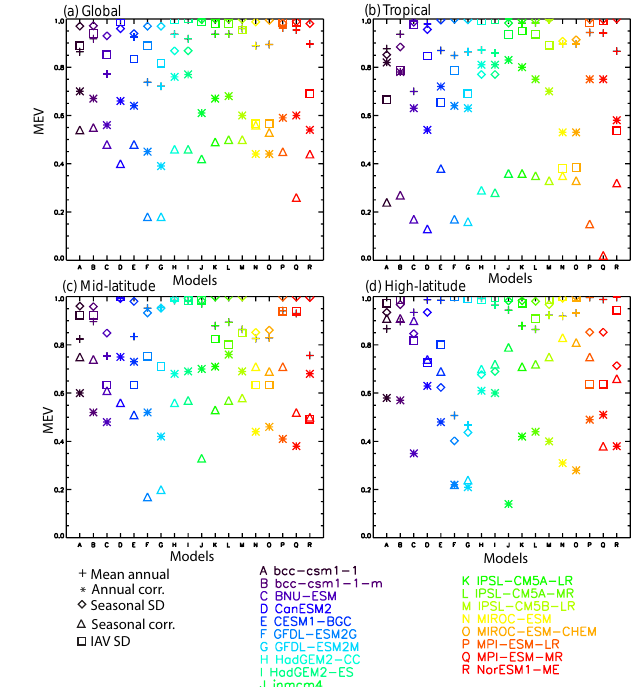
Figure 9. Comparison of model metrics for the annual mean and seasonal metrics from Table 2 across the models for (a) global, (b) tropical, (c) mid-latitude and (d) high-latitude regions. Simi- lar information is shown in Tables S1 and S2, but here converted to the model evaluation value (Eq. 1) so that 1 is a perfect model simulation and lower values indicate worse simulations. Models are shown in Table 1, and listed in the figure. Metrics are mean annual ( + ), spatial correlation of mean annual ( ∗ ), seasonal cycle standard deviation(diamond), mean seasonal cycle correlation (triangle) and interannual variability (IAV) standard deviation